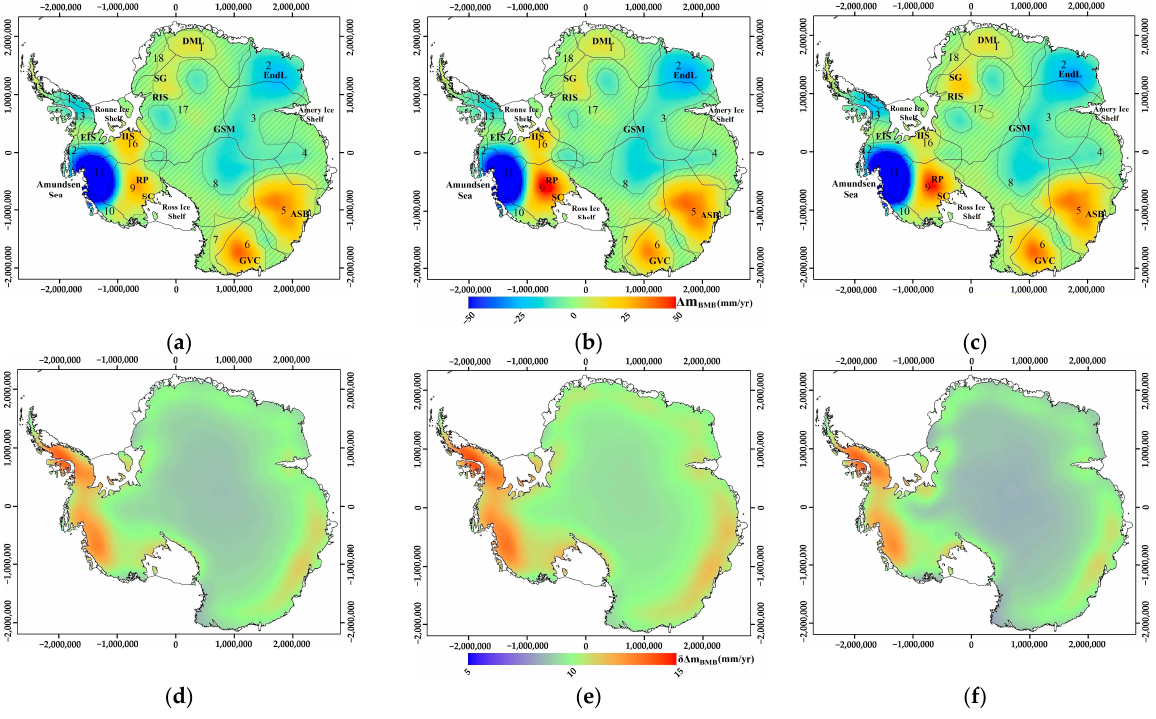
Figure 10. Spatial distribution of BMB related to ( a ) ICE-6G, ( b ) IJ05_R2 and ( c ) W12a in unit of mm/yr, and ( d – f ) associated standard deviations. Shadows are regions where the absolute values of BMB rates are lower than the associated standard deviations. SC = Siple Coast; DML = Dronning Maud Land; EndL = Enderby Land; ASB = Aurora Subglacial Basin; IIS = Institute Ice Stream; GVC = George V Coast; RIS = Recovery Ice Stream; SG = Slessor Glacier; RP = Rockefeller Plateau; GSM = Gamburtsev Subglacial Mountain.